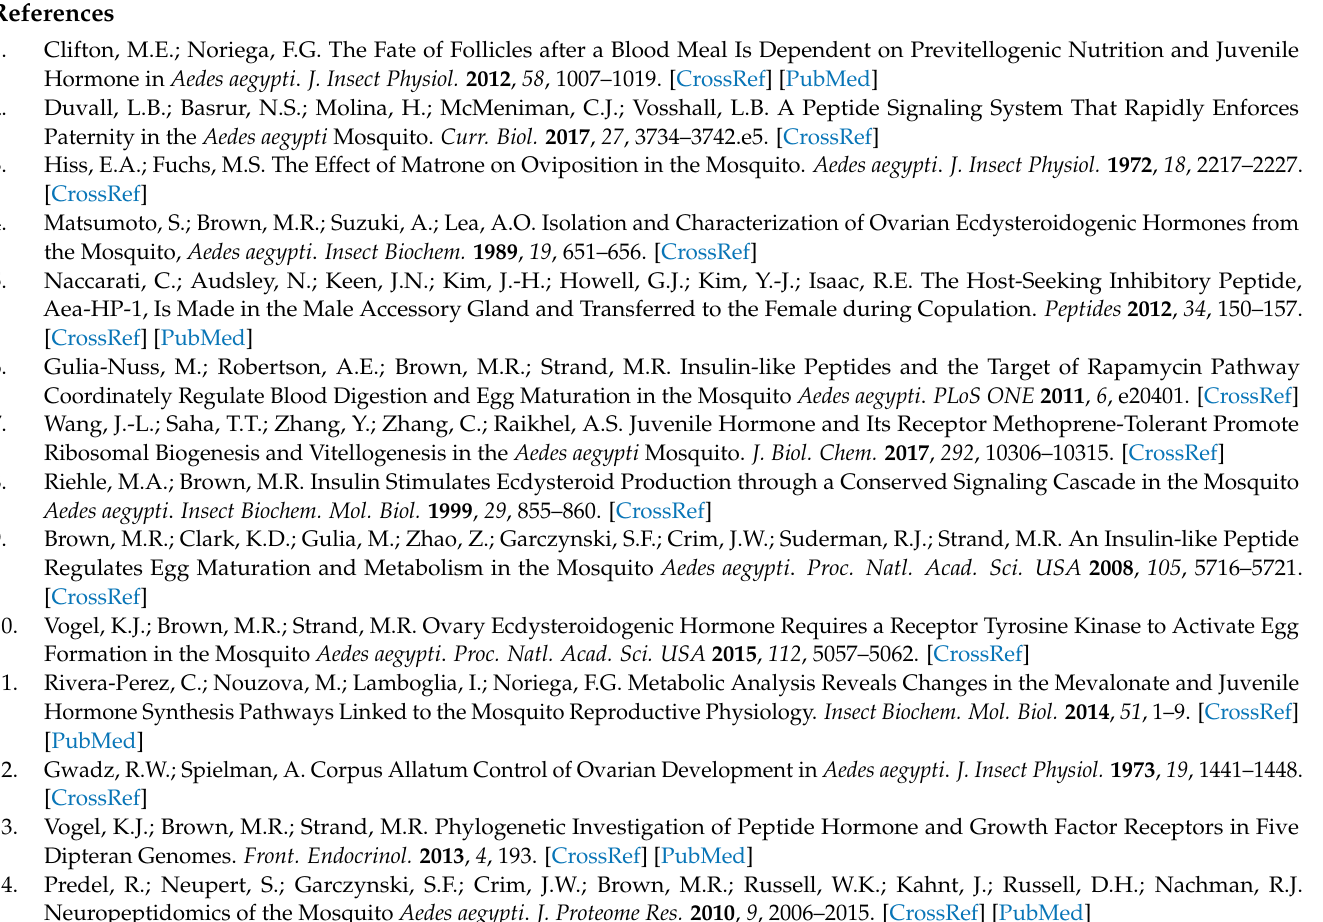
study; Figure S1: Validation of receptor activation by CNMa; Figure S2: AeCNMa and AeCNMaR-1b expression in larvae and pupae; Figure S3: Illustration of yolk-length